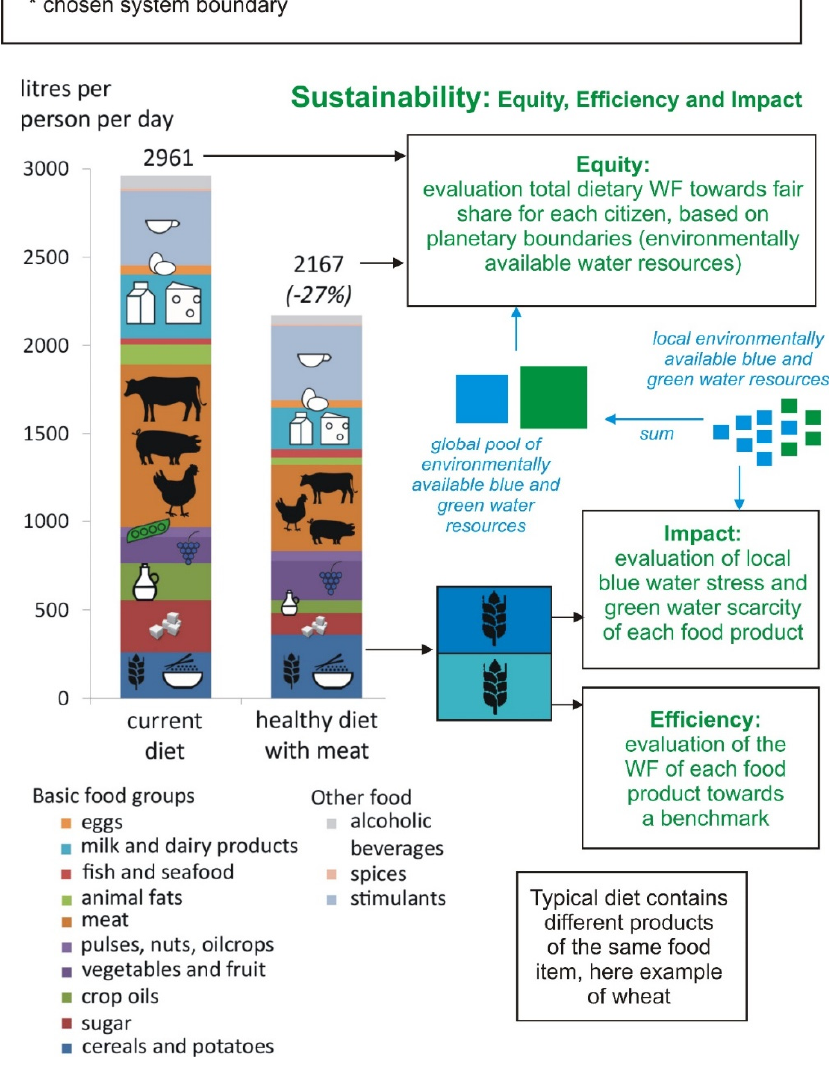
Figure 2. The green plus blue dietary water footprint (WF) of Berlin, for the current diet as well as a healthy diet including meat (data from Vanham et al. [34]). The figure also lists the different kinds of information contained in a dietary WF as well as the three aspects to evaluate the environmental sustainability (with respect to water quantity) of a dietary WF.